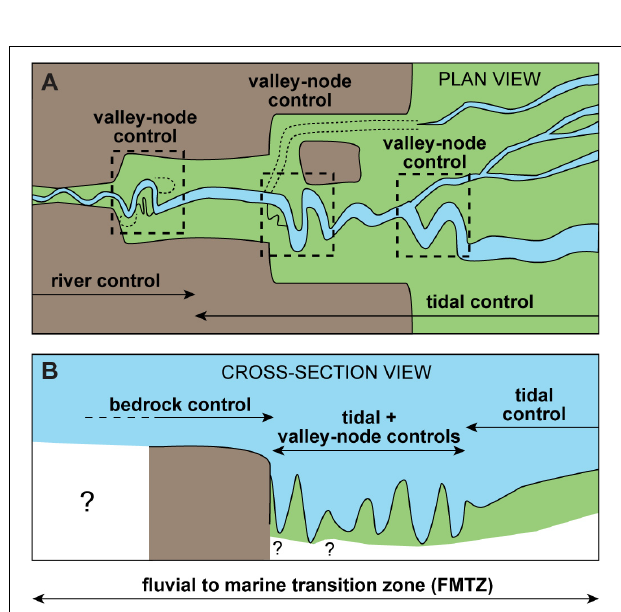
FIGURE 7 | (A–F) Plots showing the relationships between valley width, channel width, channel sinuosity, and channel bed elevation.